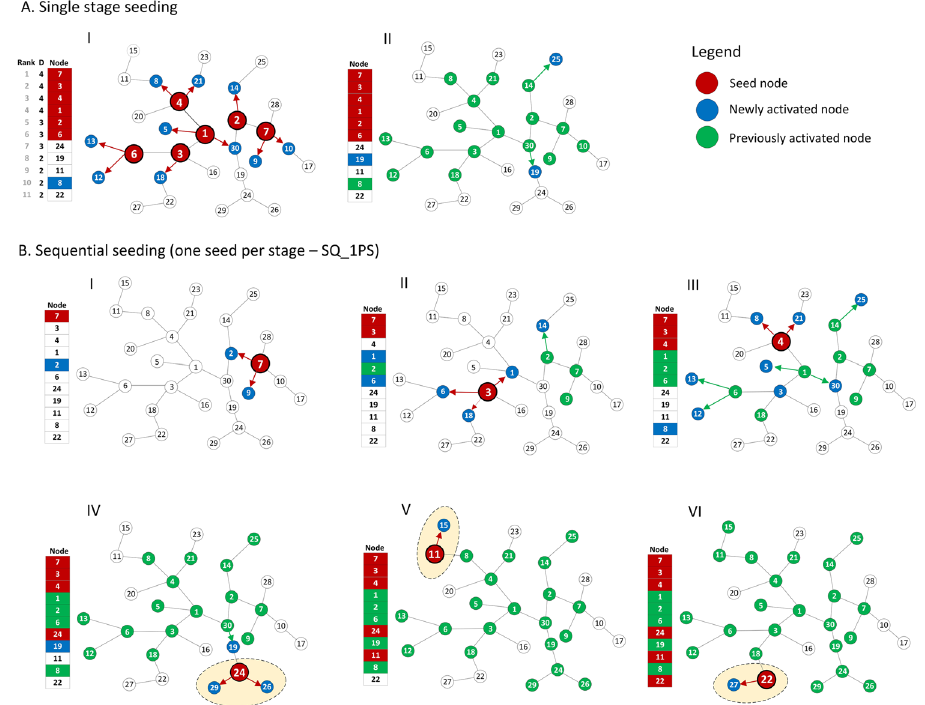
Figure 3. ( A ) Single stage seeding process (SN) with top degree ranking. ( I ) An initial set of 6 seeds (red color) consists of the nodes with the highest degree ranking. The seeds activate with probability PP = 0.5 their neighbors causing 10 of them to become active. In the next step ( II ), all newly activated nodes are contacting their non-active neighbors, activating two of them. This process ends with the total of 18 activated nodes. ( B ) One per stage sequential seeding strategy (SQ_1PS) with top degree node ranking. ( I ) A node with the highest degree is selected as the first seed. Since four nodes have the same degree, node 7 is selected randomly. It tries to activate its neighbors with PP = 0.5 and nodes 2 and 9 become active. Node 2, seeded in SN (AI) is activated by diffusion. ( II ) Node 3 is the second seed. At this stage, three nodes being seeds in the SN process, i.e. 1, 2, 6 are activated by other nodes; three other nodes can take their place as seeds. ( III ) Node 4 is taken as the third seed. ( IV ) The fourth seed is node 24 – it did not belong to seeds in the SN process. It could become a seed because all nodes preceding it in the ranking have already been activated. So far, 20 nodes are activated in four steps comparing to 18 in the SN strategy, and there are two more seeds left to activate. ( V ) The fifth seed is node 11. Since the other nodes do not activate any new ones, the process would terminate now with totally 22 activated nodes. However, one more seed is still available. ( VI ) The last seed is node 22 which activates node 27. It cannot activate anyone else, so diffusion stops with 24 activated nodes. New parts of the network reached with the sequential seeding are